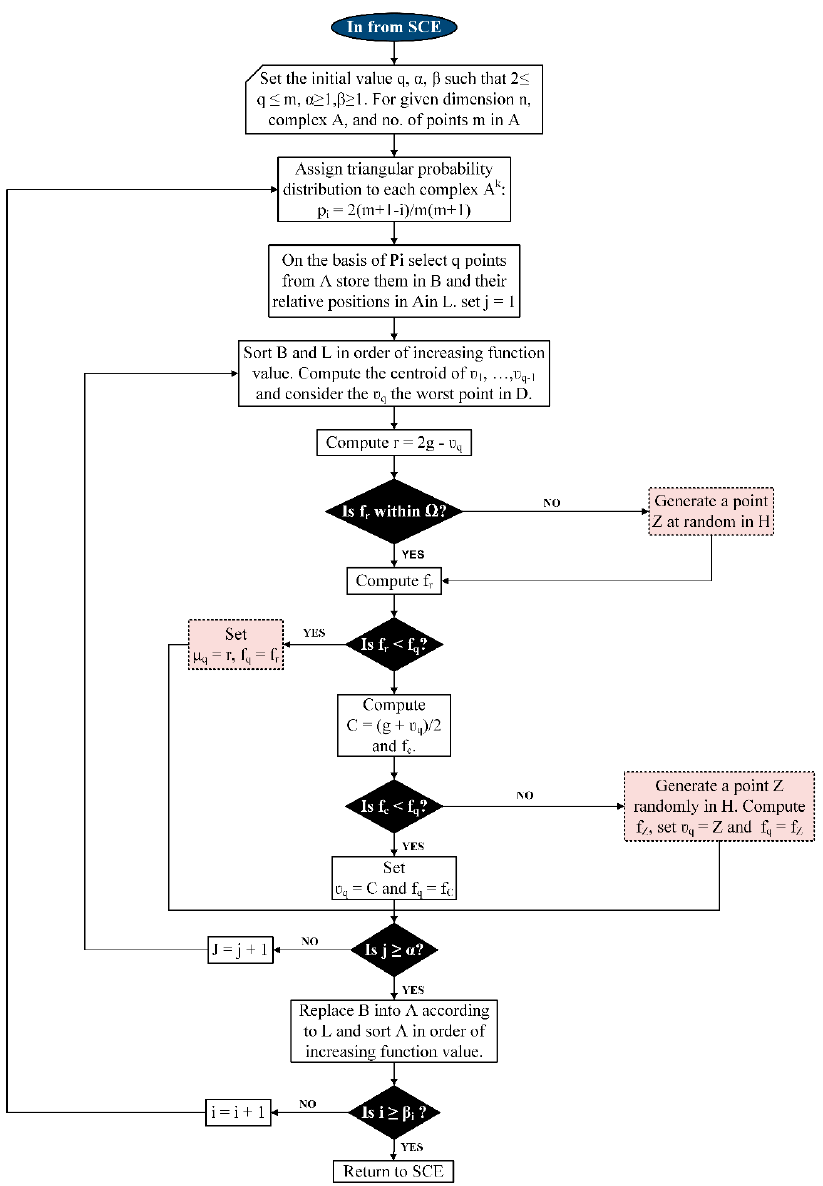
Figure 2. Flowchart of the competitive complex evolution (CCE) method.